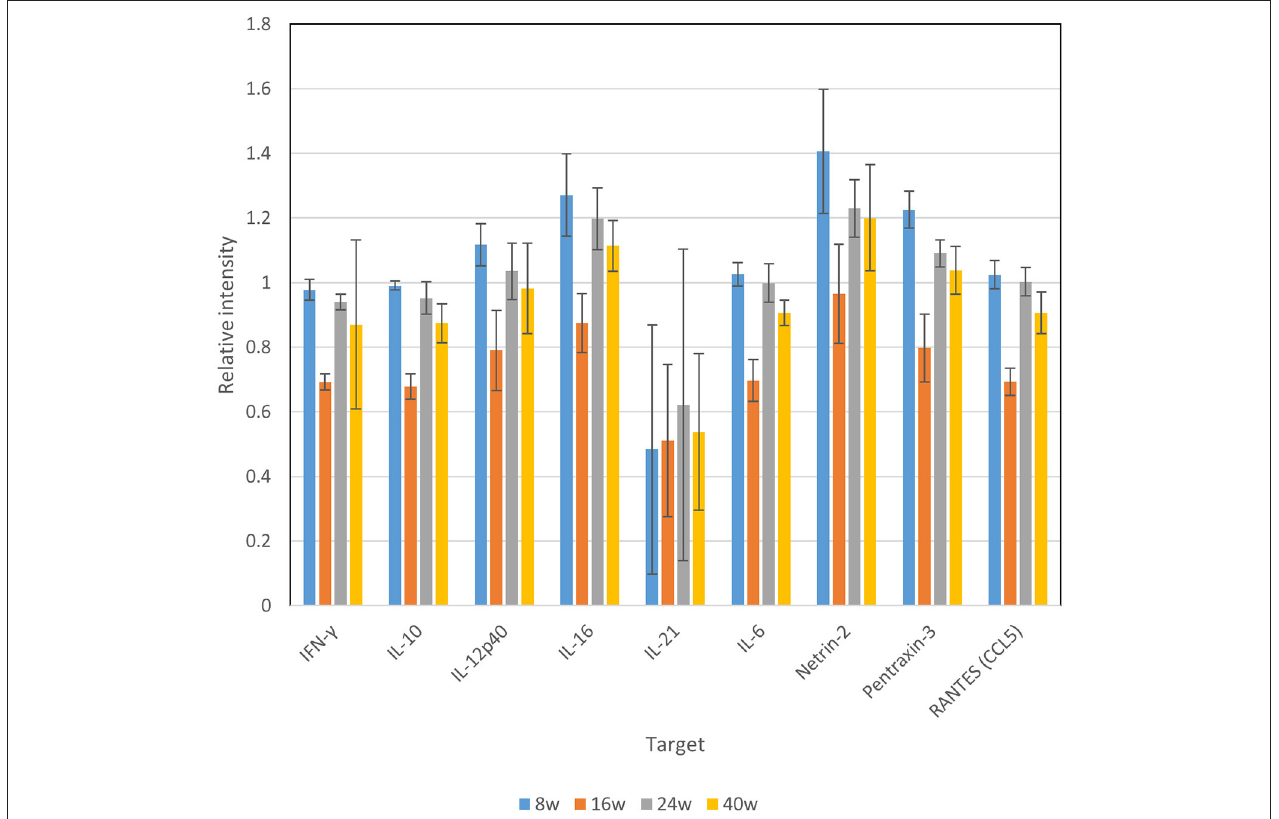
FIGURE 3 | Cytokine production in the sera of laying hens after experimental C. jejuni infection. the gut microbiota and lipids were observed, suggesting their possible